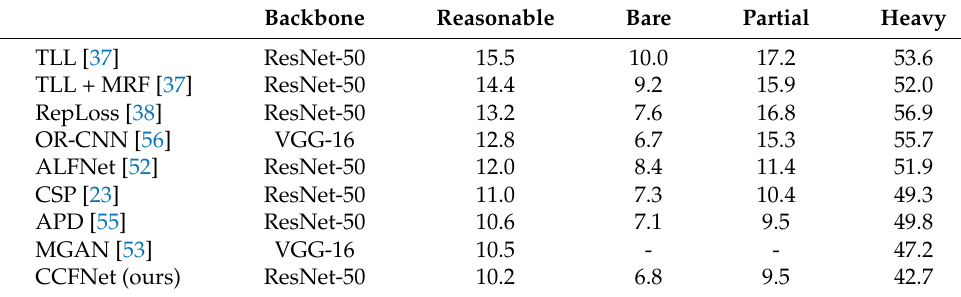
Table 7. The results of various models on the CityPersons